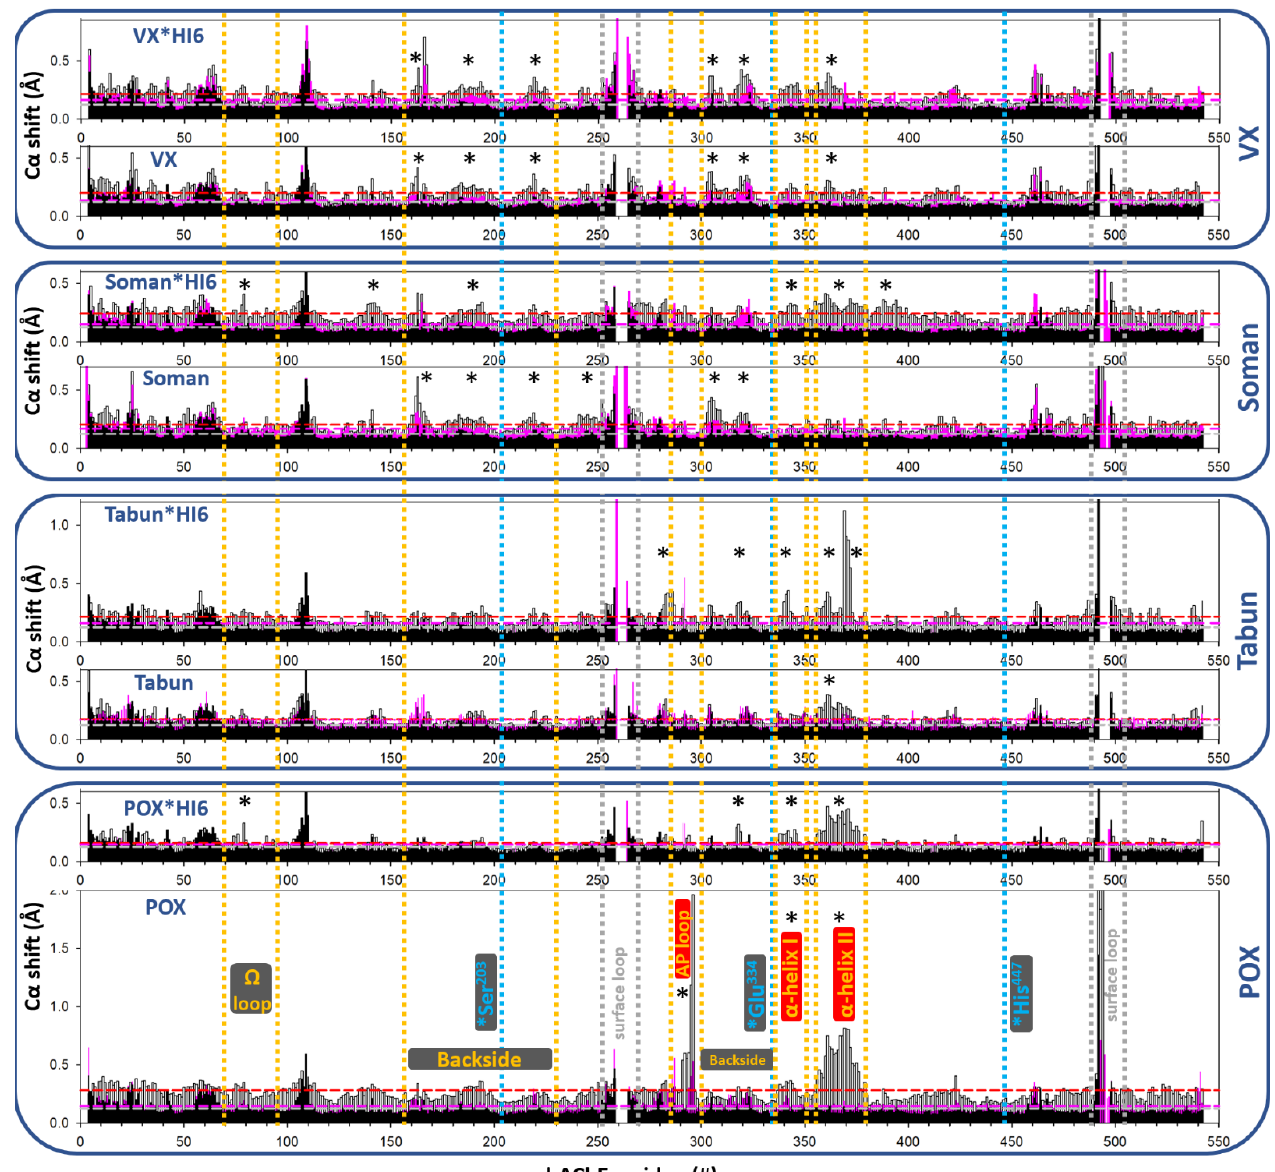
Figure 4. Alpha carbon shifts in hAChE backbone upon covalent conjugation by OPs as indicated in each panel and further reversible complex formation with HI6. Each X-ray structure is compared to Apo hAChE structure (PDB ID 4EY4) in a pairwise fashion using PACCT 3 tool. Black and magenta bars represent baseline obtained by pairwise comparison of chains A and B of the same structure (black for 4EY4 and magenta for each of analyzed structures as labelled above). White bars indicate difference between chains A of each indicated structure and Apo hAChE (4EY4). Average values of Cα shifts for baselines are indicated by horizontal dashed lines: black for Apo hAChE and magenta for the structure compared. Red, dashed horizontal line indicates average shift obtained from white bars. Location of different structural elements in the linear hAChE amino acid sequence, as well as position of catalytic triad residues is indicated with vertical dashed lines. Those elements are mapped onto 3D structural backbone of hAChE in Figure 5. Asterisks indicate significant shifts in Cα.